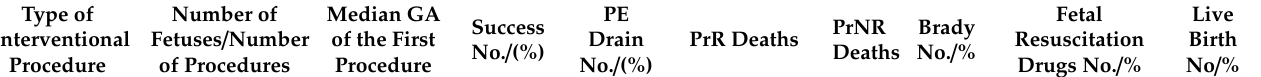
Table 1. Technical aspects of all fetal cardiac procedures between June 2011 and April